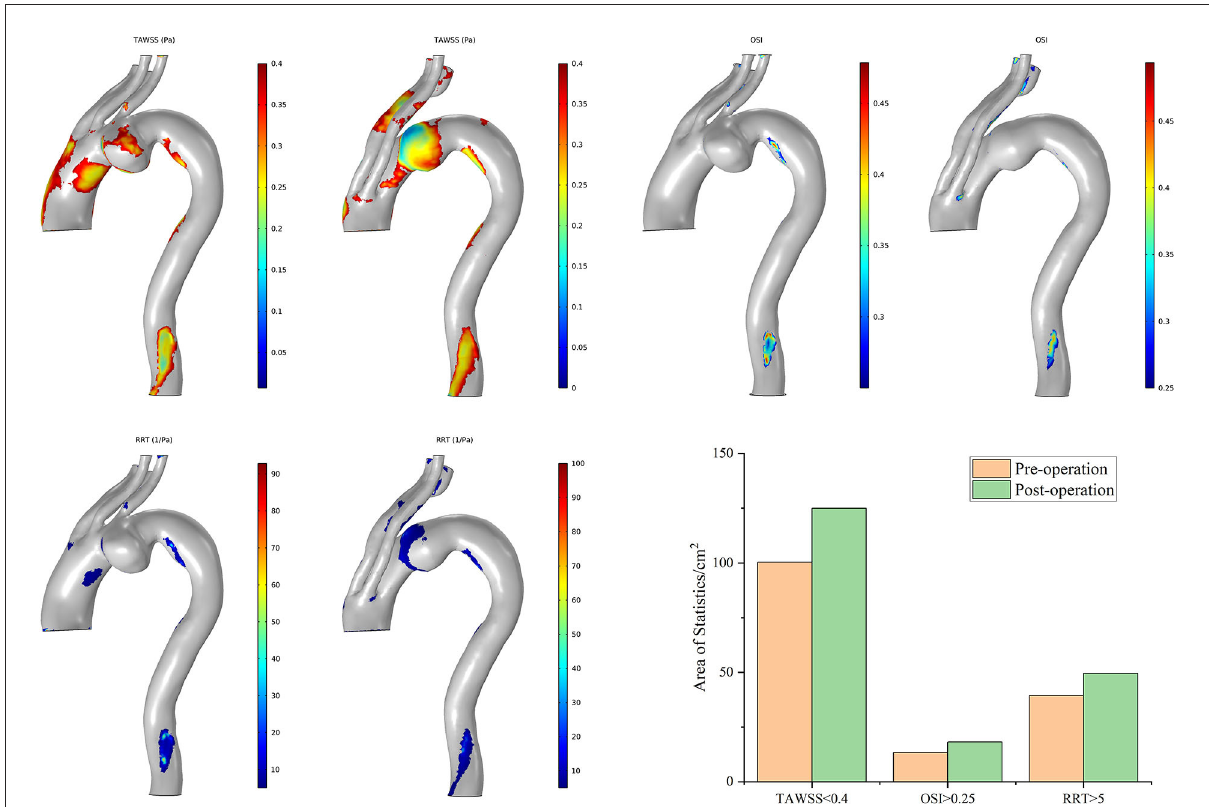
FIGURE10 Distributions of changes in TAWSS, OSI, and RRT in Case 3. The hemodynamic characteristic regions are visually illustrated as a color distribution nephogram with each indicator in a group (left, preoperative; right, postoperative). Areas were calculated and illustrated in the bar graph. OSI, oscillatory shear index; RRT, relative residence time; TAWSS, time-averaged wall shear